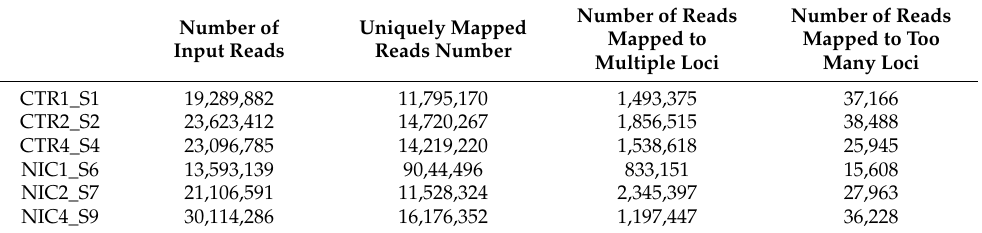
Table 1. Summary of sequencing reads before and after STAR/RSEM alignment and quantification. Number of Uniquely Mapped Input Reads Reads